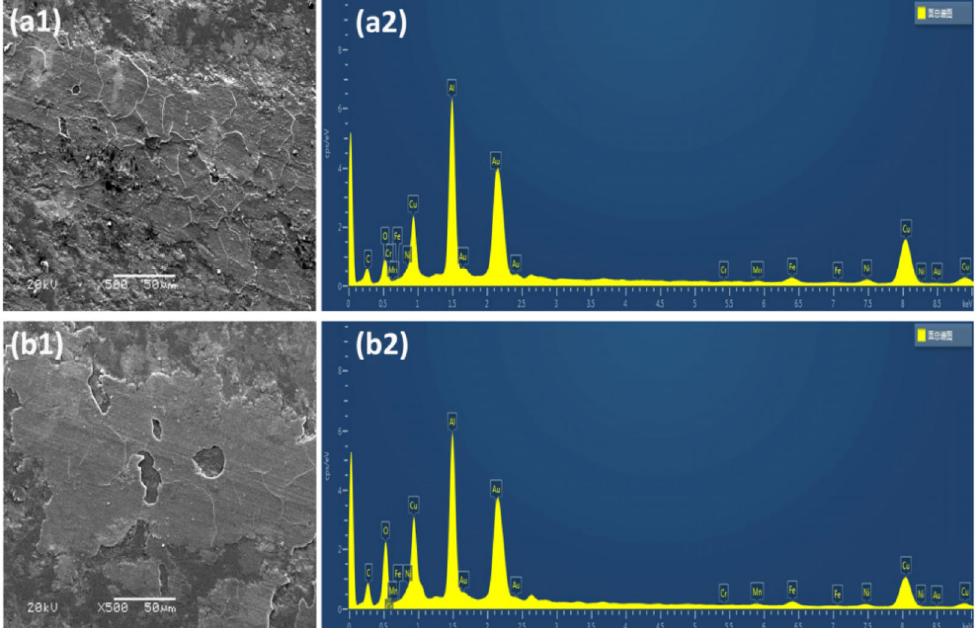
Fig. 8 SEM images and energy dispersive spectroscopy of counterfaces after sliding in seawater with ((a1), (a2)) 0 M and ((b1), (b2)) 1.0 M halide